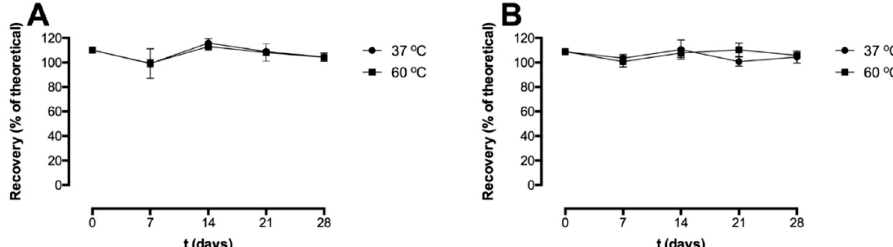
Figure 2. Recovery (% of theoretical) of the freeze-dried pre-F-containing powder immediately after freeze-drying and after storage at 37 °C (circle) and 60 °C (square). Two different detection antibodies were used; CR9501-biotin ( A ) and CR9506-biotin ( B ). The recovery was based on the theoretical pre-F content. For each time point, n = 3, mean and standard deviation are given.